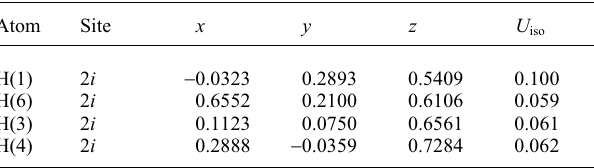
Table 2. Atomic coordinates and displacement parameters (in Å 2 )